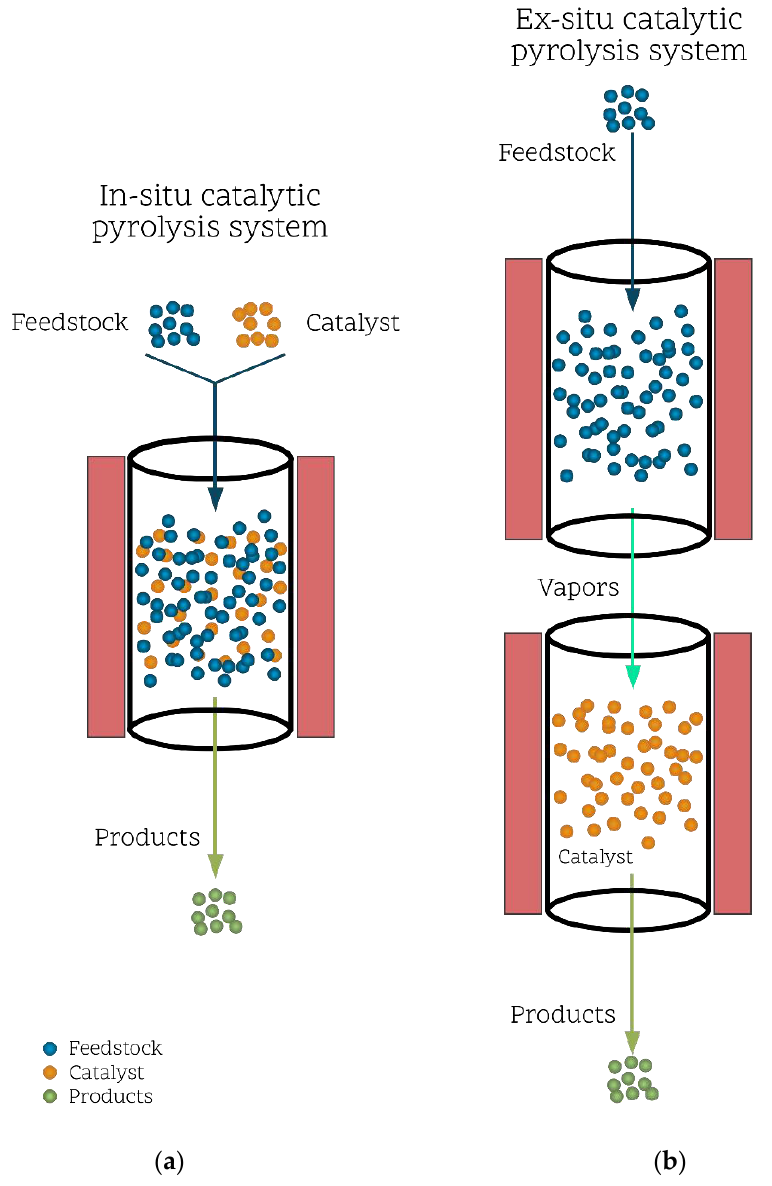
Figure 4. ( a ) In situ and ( b ) ex situ configurations of catalytic pyrolysis of biomass.